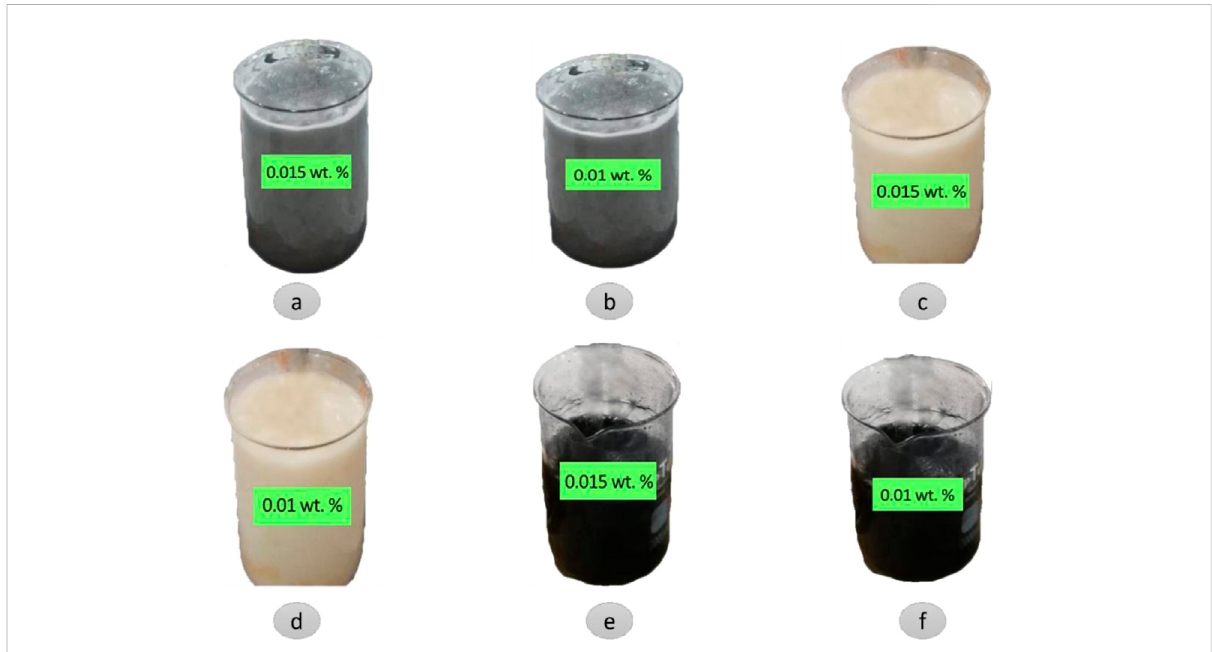
FIGURE 6 System schematic